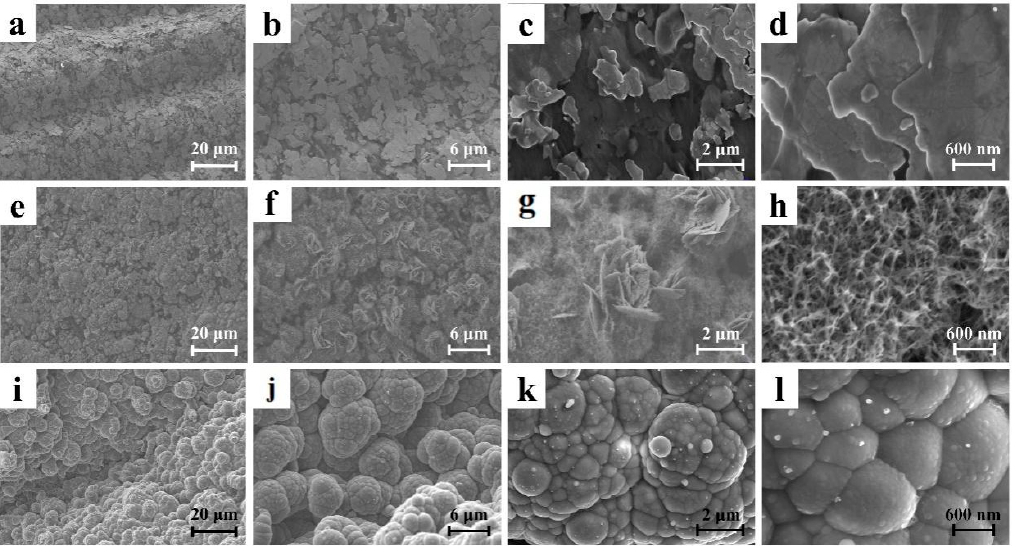
Figure 2. SEM images of ( a – d ) nylon/Ag; ( e – h ) nylon/Ag/MnO 2 and ( i – l ) nylon/Ag/PPy electrodes at di ff erent magni fi cations.